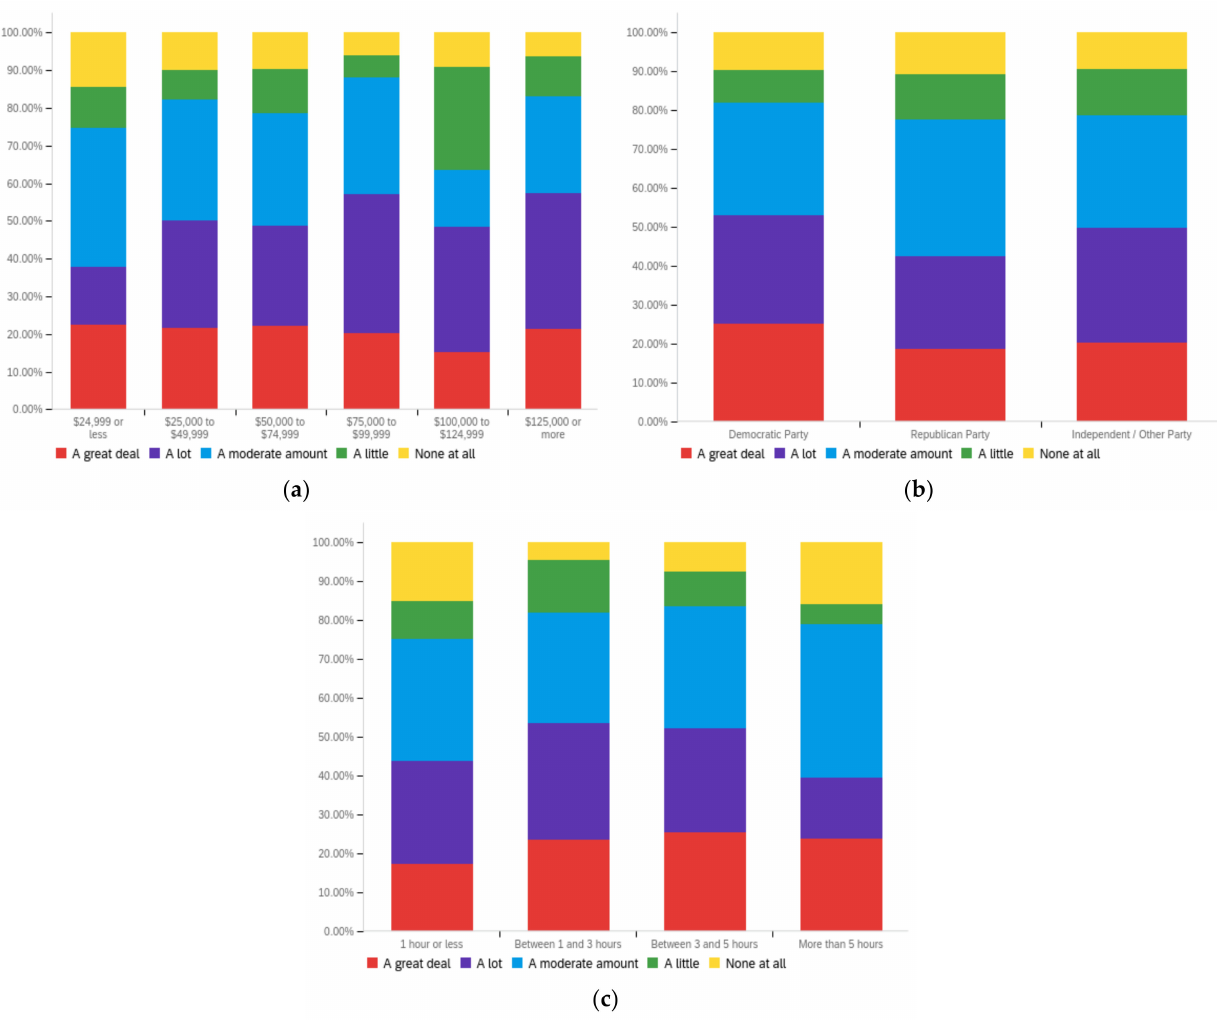
Figure A23. Article sponsor’s political alignment—others’ perception impact by: ( a ) income level (top left), ( b ) political affiliation (top right) and ( c ) online usage